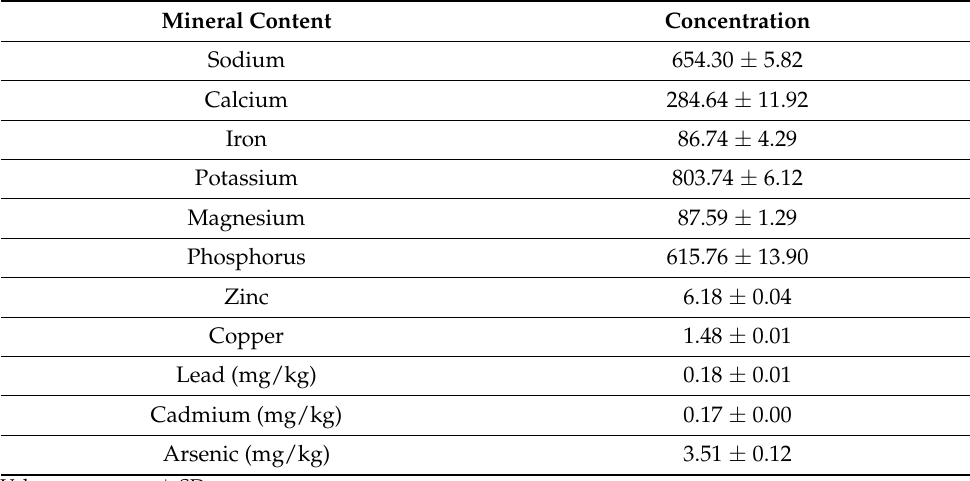
Table 4. Mineral content (mg/100